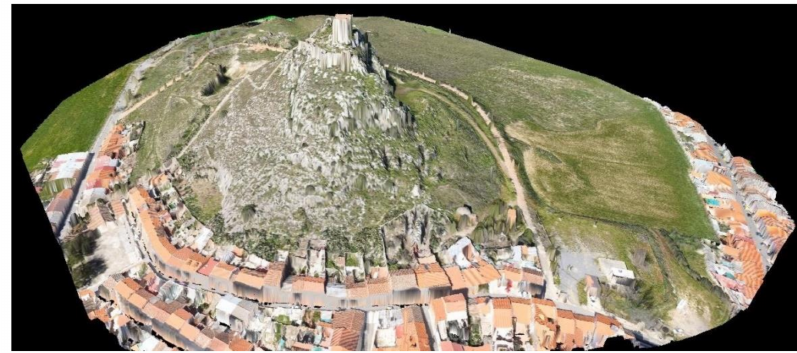
Figure 9. Results of the ortophotogrammetric acquisitions of the CCB. Images from ZNIR for “Ager Mellariensis” / AEI FEDER HAR 77136-R.